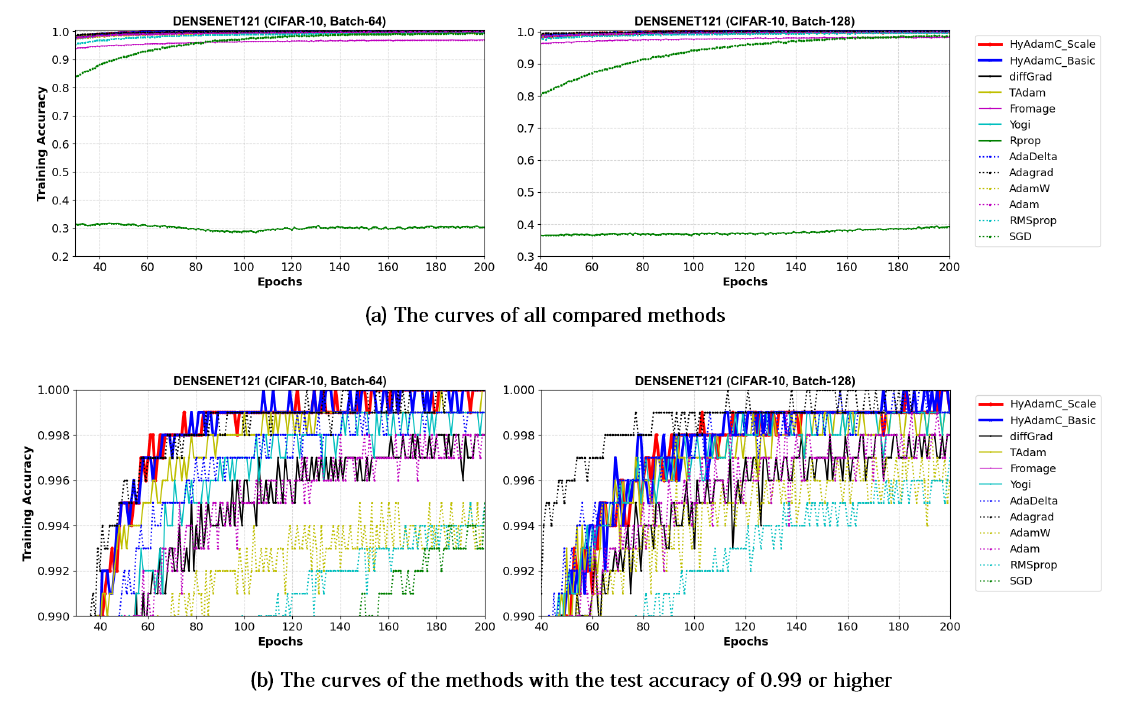
Figure 21. The training accuracy curves of the DenseNet-121 trained by HyAdamC and other optimization methods in the CIFAR-10 image classification tasks. In this figure, ( a ) shows the training accuracy curves of all compared methods. On the other hand, ( b ) illustrates the plots in which a range of the y-axis of the plots described in ( a ) is zoomed into between 0.99 and 1.